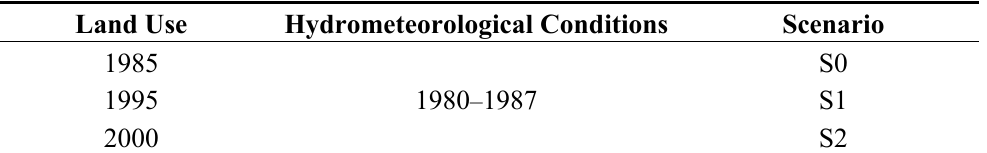
Table 2. Hydrological simulation